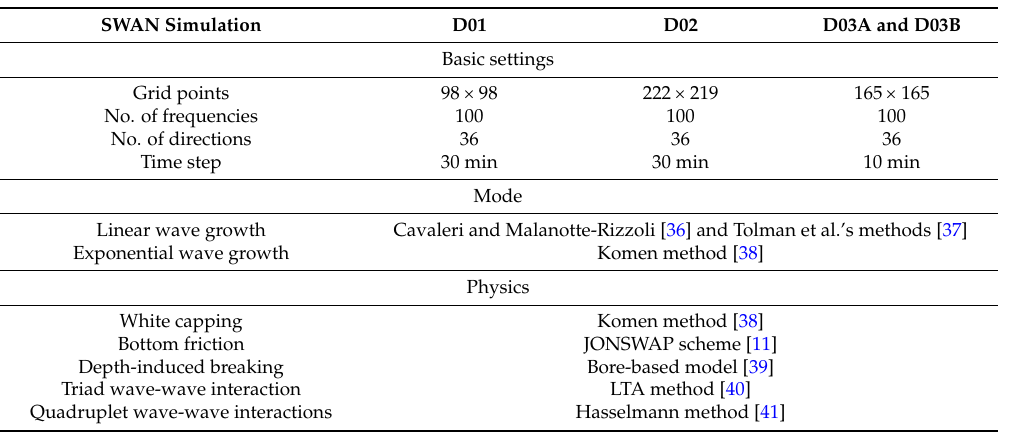
Table 3. Detailed settings of the SWAN model. LTA: lumped triad